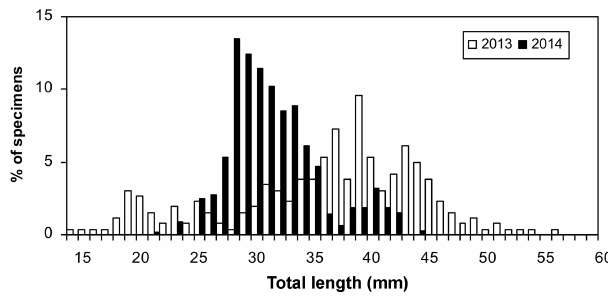
Figure 4. Length–frequency distributions of early life stages of sar- dine collected in the Gulf of Manfredonia.